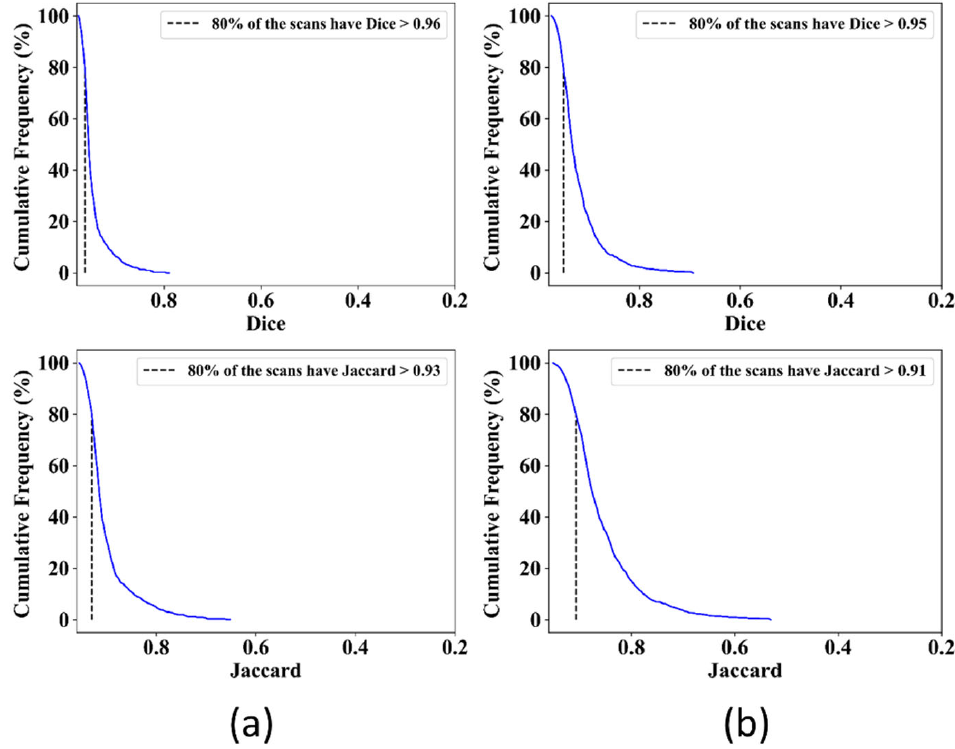
Figure 14. Cumulative Frequency curves showing Dice (top) and Jaccard (bottom) for ( a ): UNet model, ( b ): UNet+ model.